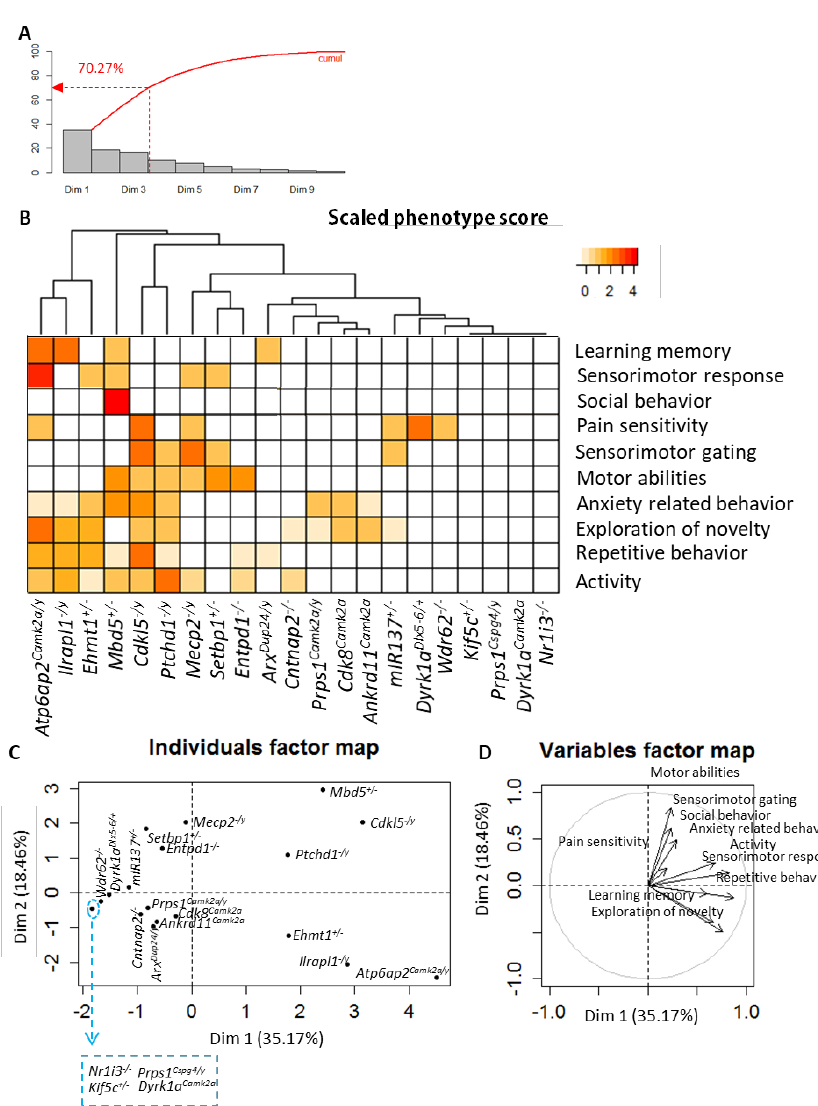
Figure 5. ( A ) PCA—Percentage of explained variance in principal component analysis for each component and cumulated percentage of explained variance. ( B ) Heatmap of scaled phenotype scores data. Row dendrograms show the distance between mutant lines and arrangement produced by hierarchical clustering. Colours indicate the phenotype score level. The darker the orange, the more phenotype parameters the biological function has. ( C ) PCA—Individuals factor map shows in axes 1 and 2 similarity of components between mutant lines. Note: 4 mutant lines listed in the blue square have the same coordinates. ( D ) PCA—Variables factor maps or correlations circle shows in axes 1 and 2 links between biological functions and the